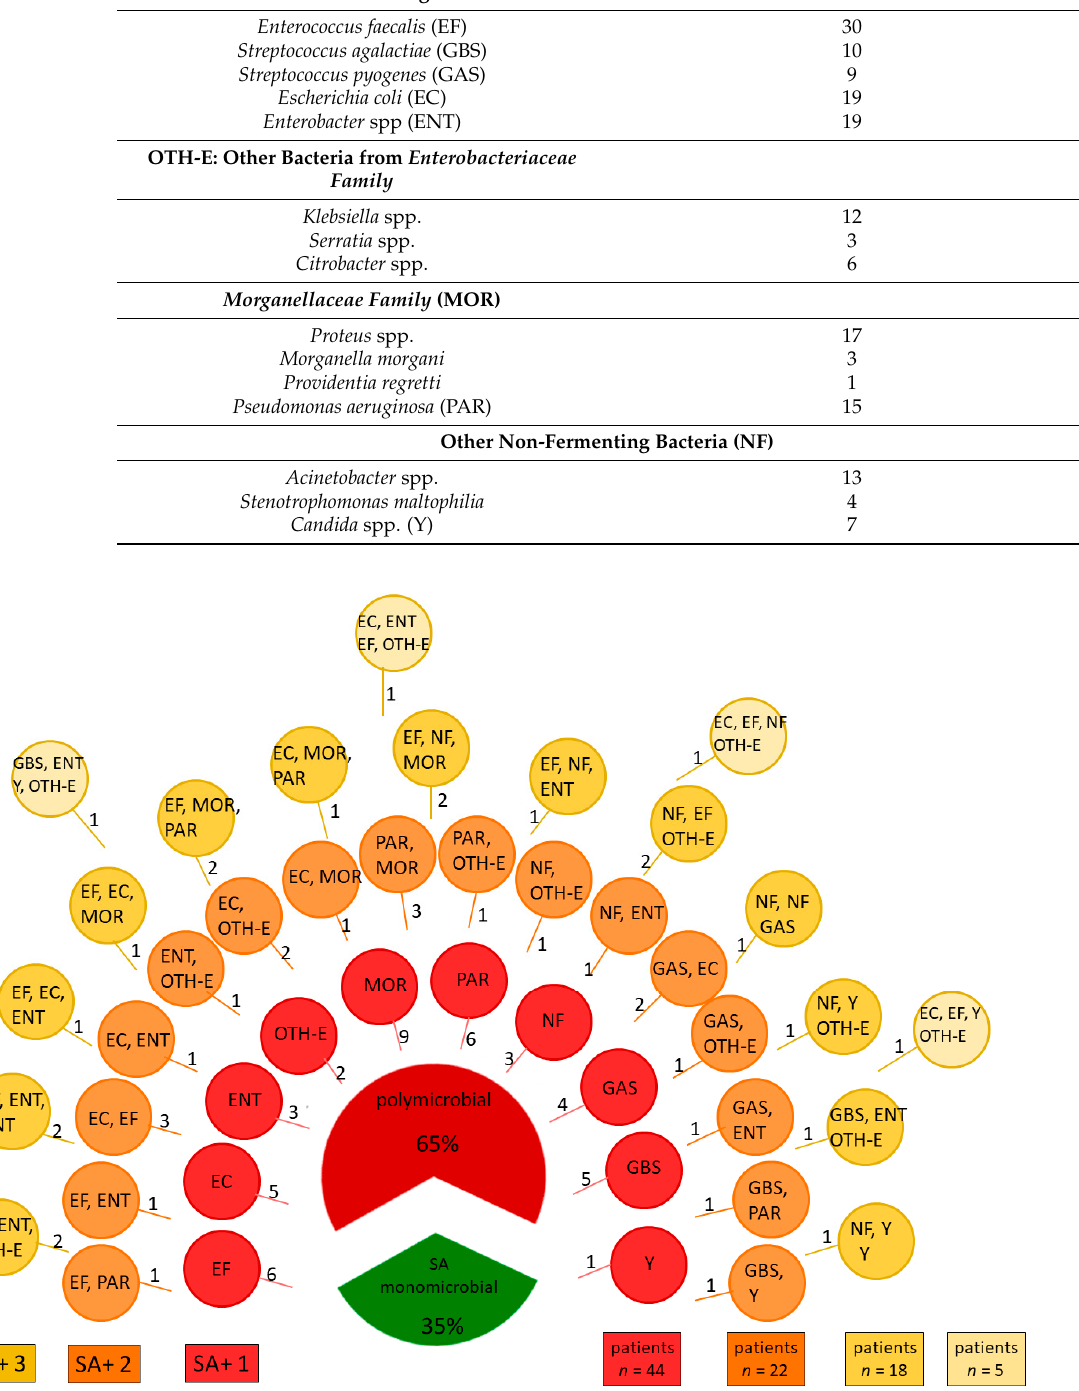
Figure 1. Microbiota isolated from infected venous ulcers from 143 patients, numbers indicate numbers of patients. Leg- end : EC Escherichia coli ; EF Enterococcus faecalis ; ENT Enterobacter spp.; GAS Streptococcus group A ; GBS Streptococcus group B ; MOR bacteria from Morganellaceae family; NF other non fermenting bacteria; OTH-E other bacteria from Enterobacteriaceae family ; PAR Pseudomonas aeruginosa ; SA Staphylococcus aureus ; Y yeast. n —number of patients in the group with one, two, three or four pathogens in addition to SA in the polymicrobial group,